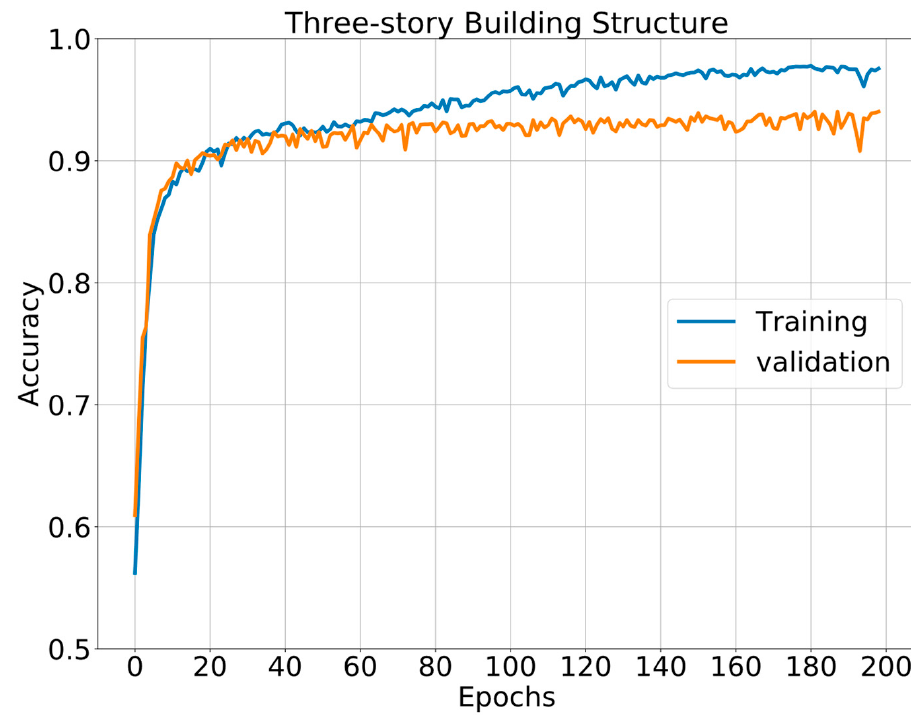
Figure 7. Accuracy curves of EEMD-PCC-CNN during the training procedure.